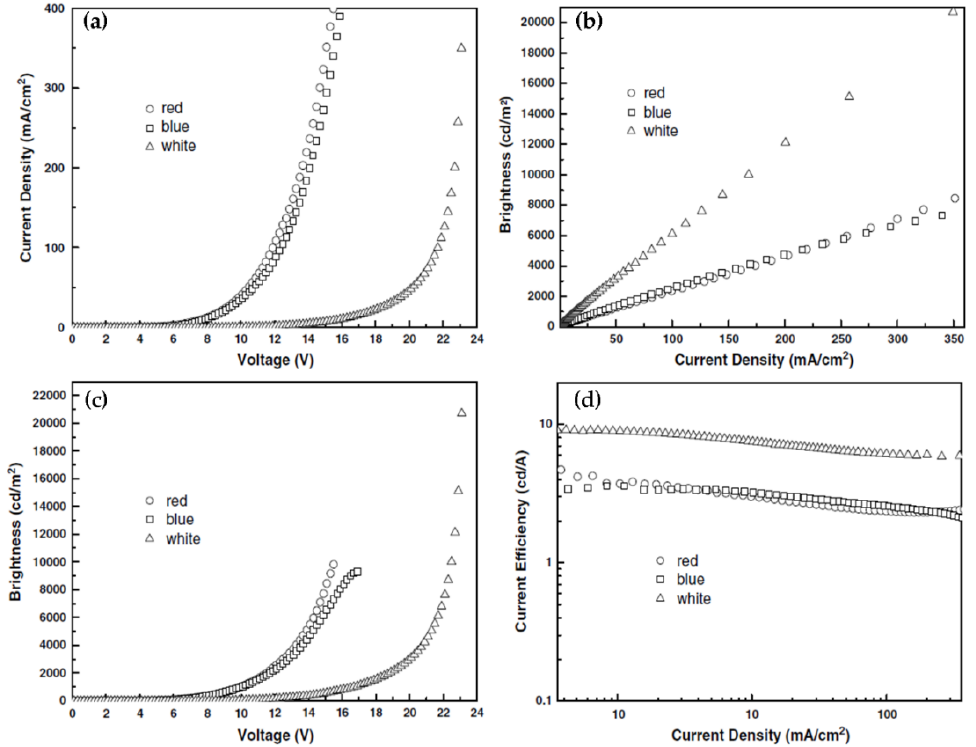
Figure 8. EL performance of tandem white OLED (triangles), the control blue device (squares), and the control red device (circles): ( a ) current–voltage, ( b ) brightness–current, ( c ) brightness–voltage, and ( d ) current efficiency–current. Reproduced or adapted from [41].